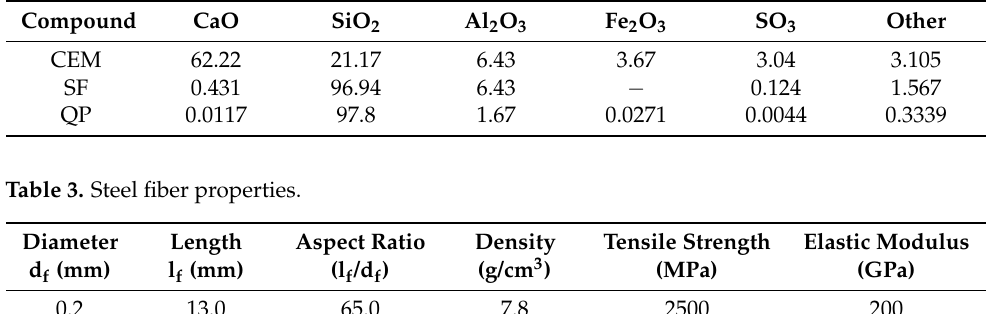
Table 2. The chemical compositions of cementitious materials (%).